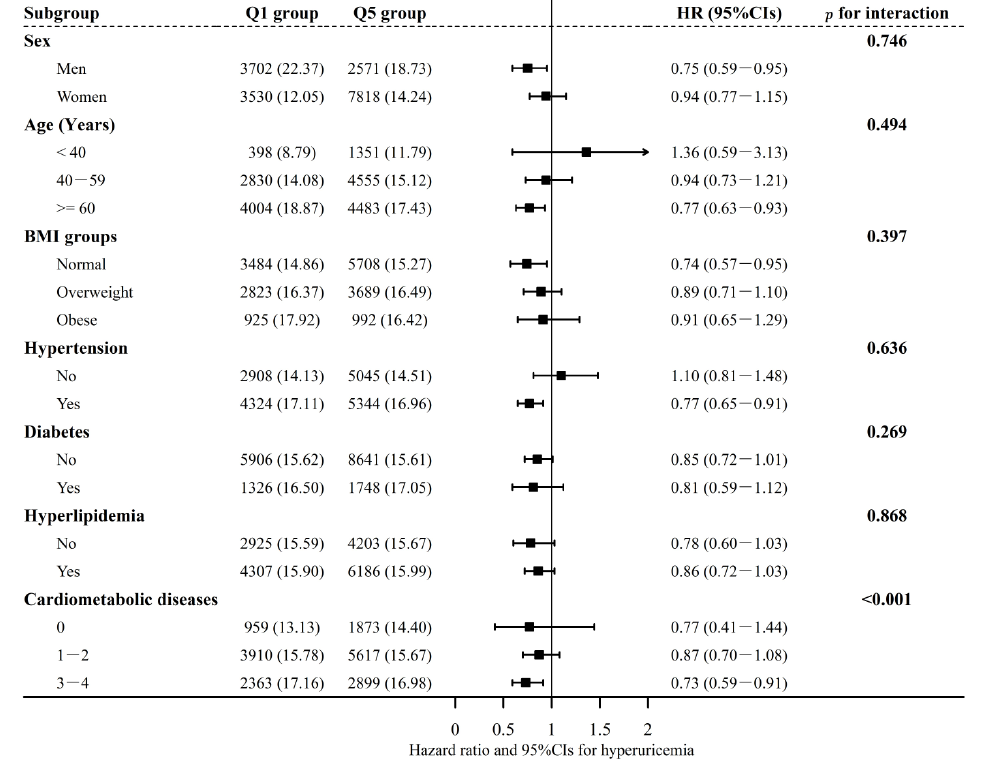
Figure 3. The association between DASH dietary groups with incident hyperuricemia in subgroups: a comparison of two extreme groups. The model was fully adjusted for age, sex, marital status, education level, family history, BMI groups, hypertension, diabetes, hyperlipemia, smoking, alcohol drinking, PA, and total energy intake at baseline. Each subgroup analysis was adjusted for all the covariates listed above except itself. Text in bold was used to indicate the summary value of subgroups. Arrows were used where the upper confidence intervals exceeds 2.00.